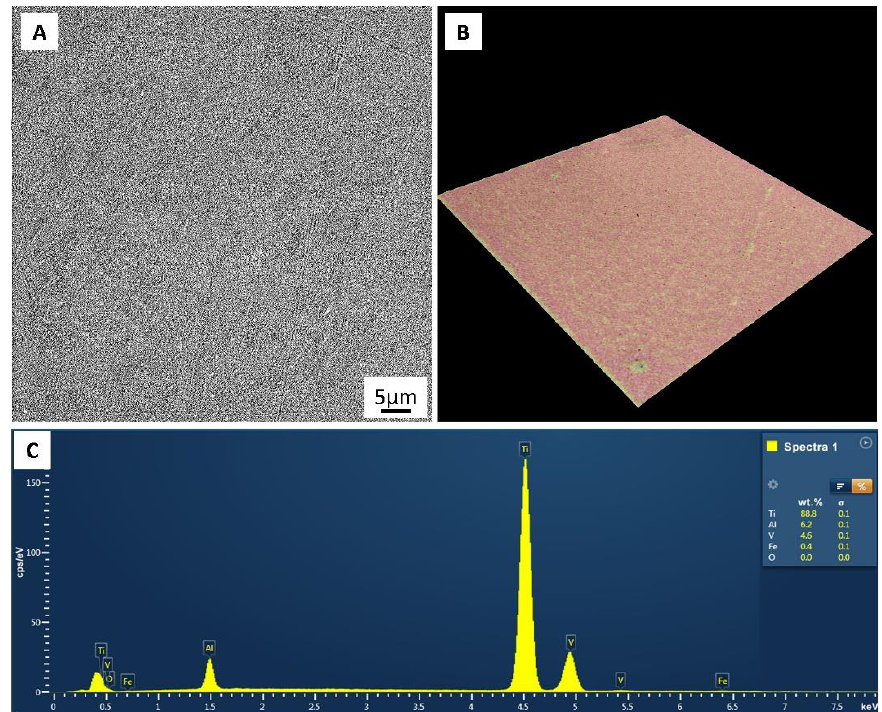
Figure 1. Substrate surface morphology ( A ), profile of the substrate surface ( B ), and elemental analysis of the surface of substrate ( C ).